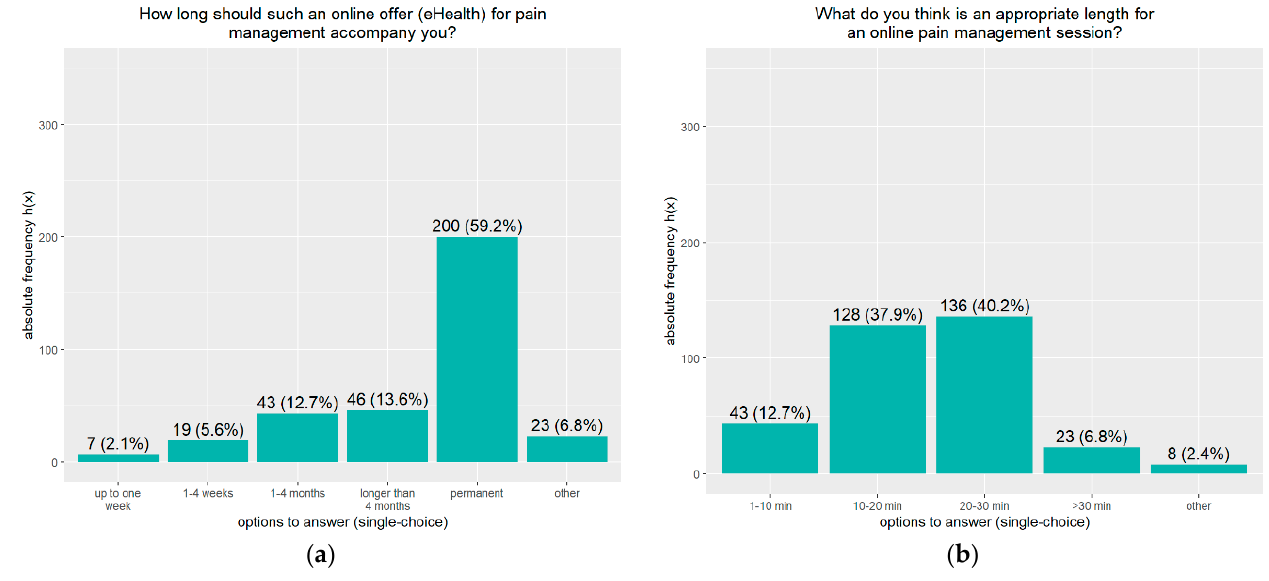
Figure A3. n = 327. Eleven subjects were excluded since they did not answer the question fully. Shown above are the participants’ responses regarding formats’ suitability for communicating pain- related content. Deviations in the direction of approval and rejection are shown on the right or left in percentual frequencies.